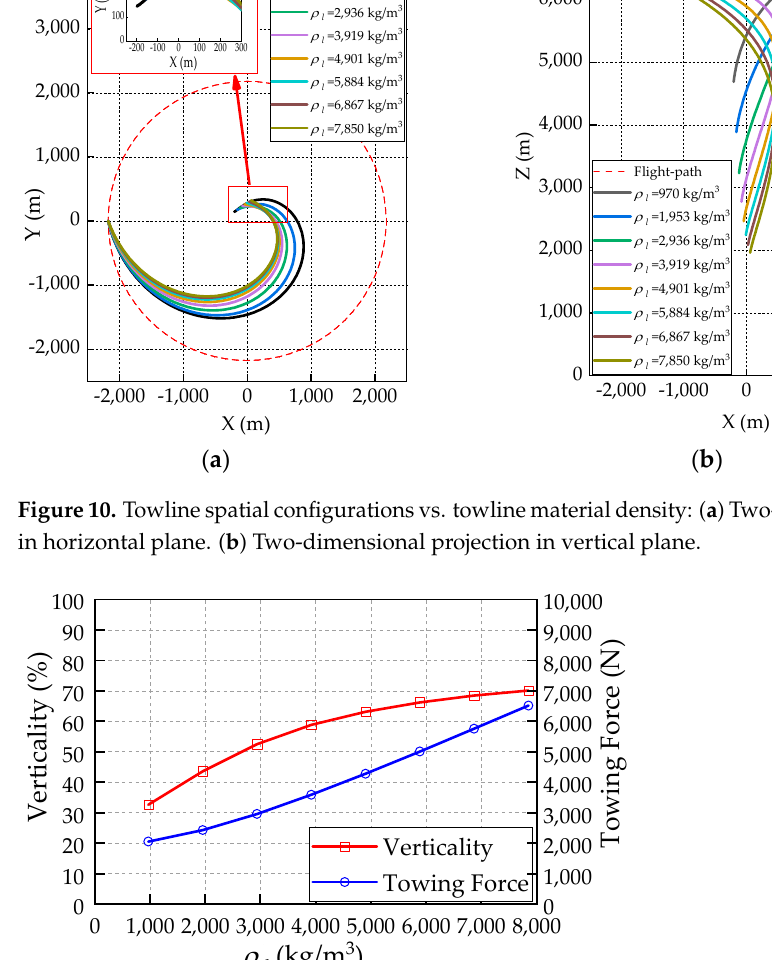
( b ) Figure 12. Towline spatial configurations vs. towline length: ( a ) Two-dimensional projection in horizontal plane. ( b ) Two-dimensional projection in vertical plane. Figure 13 illustrates that the towline length greatly influences verticality and towing force, and inflection points appear on both curves. Initially, when the length varied from 1000 m to 5600 m, the verticality and towing force of the towline increased relatively gen- tly. However, when the length varied from 5600 m to 8400 m, the verticality increased quickly from 35% to about 80%, accompanied by a linear increase in the towing force from 4377 N to 8557 N. When the length exceeds 8400 m, the drogue (i.e., the end of the towline) will touch the ground. More importantly, both towing force and verticality curves reveal that there is an inflection point in the influence of antenna length on the spatial configu- ration of the antenna system. Before the inflection point, it is difficult to meet the specified standard working requirements for antenna verticality; however, after the inflection point, the antenna verticality can be easily improved.